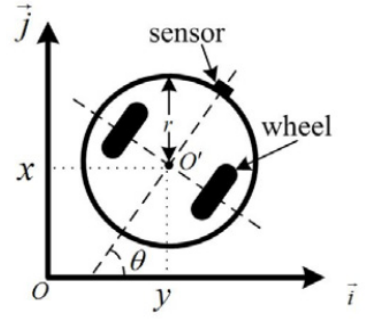
Figure 1. Sketches of the mobile robot.